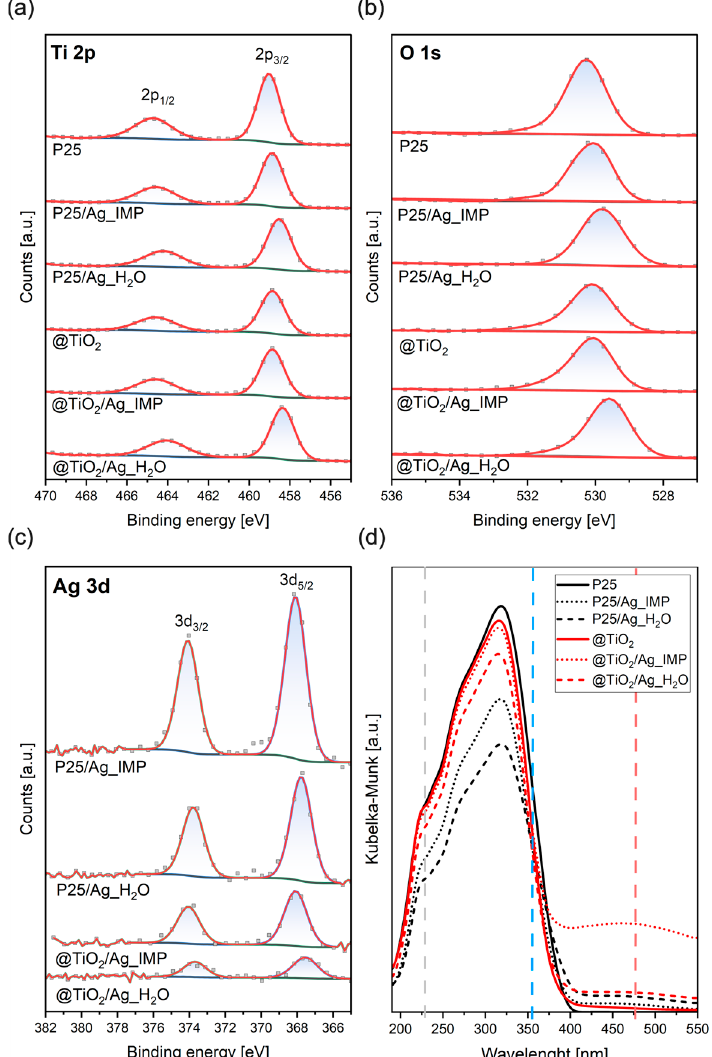
Figure 6. High resolution XPS spectra of Ti 2p ( a ), O 1s ( b ), Ag 3d ( c ) and UV-Vis-DR spectra in Kubelka–Munk function ( d ) for @TiO 2 and P25 materials before and after deposition of Ag using two different methods—IMP and H 2 O.